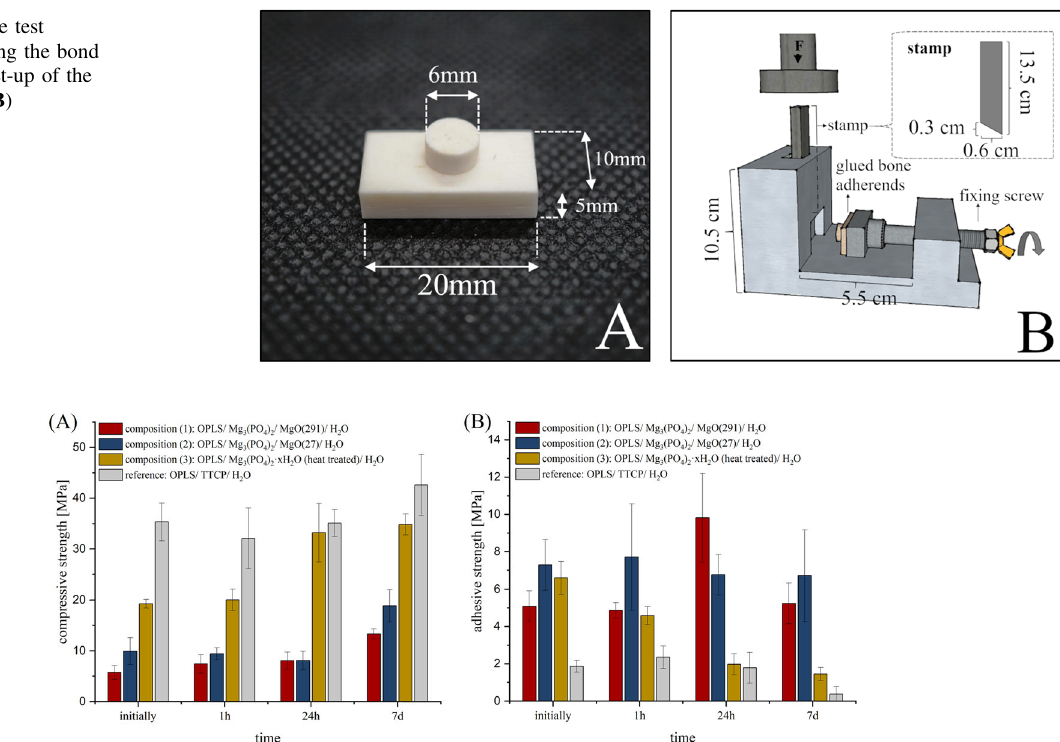
Fig. 2 A Compressive strength of cement cuboids and ( B ) adhesive strength on bovine cortical bone substrates of cements made from: red: OPLS/ Mg 3 (PO 4 ) 2 / MgO(291)/ H 2 O, blue: OPLS/ Mg 3 (PO 4 ) 2 / MgO(27)/ H 2 O, yellow: OPLS/ / Mg 3 (PO 4 ) 2 ∙ xH 2 O (heat treated.)/